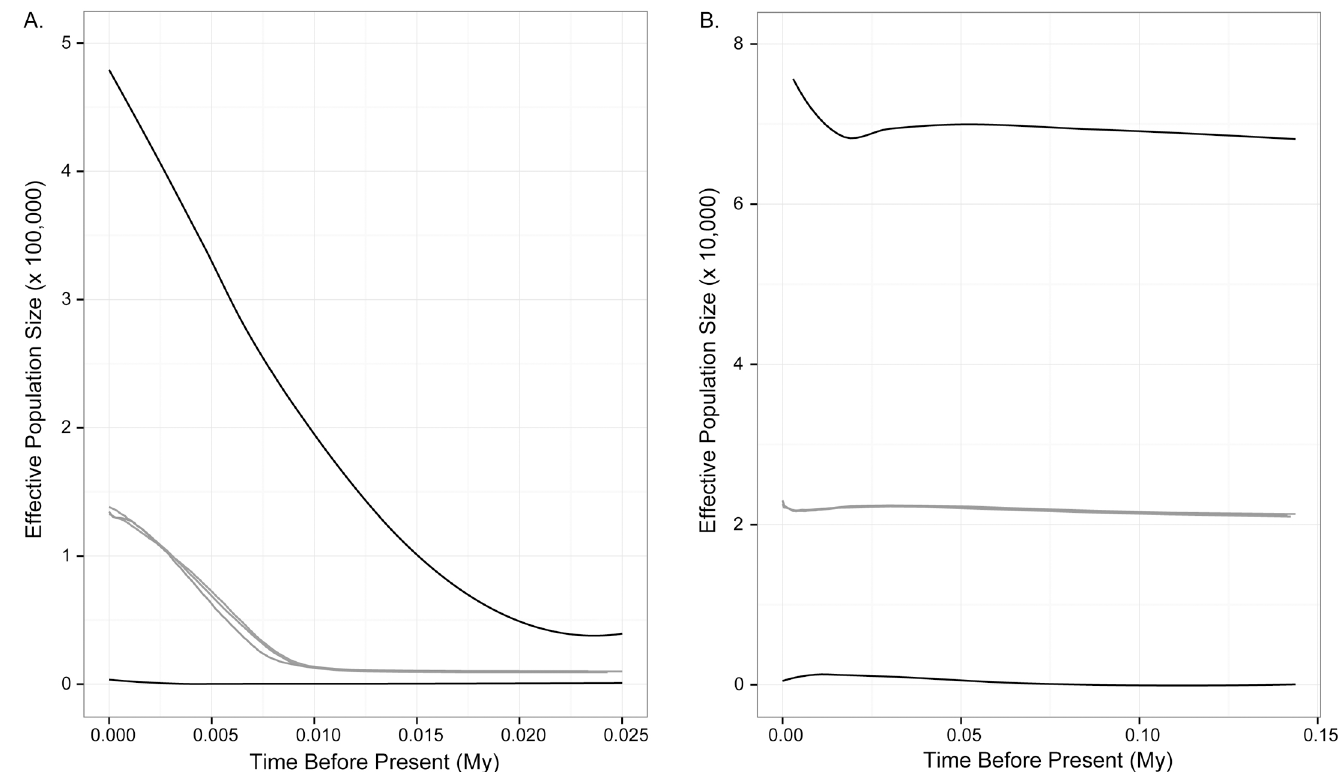
Fig 3. Extended Bayesian skyline plots for Hawaiian populations. Results of three runs are shown as gray lines, bounded by 95% confidence intervals in black. A. Skyline plot for the Hawaii1 population, showing a pattern of population growth starting at ca. 10 kya. B. Skyline plot for the Hawaii2 population, fitting a model of population